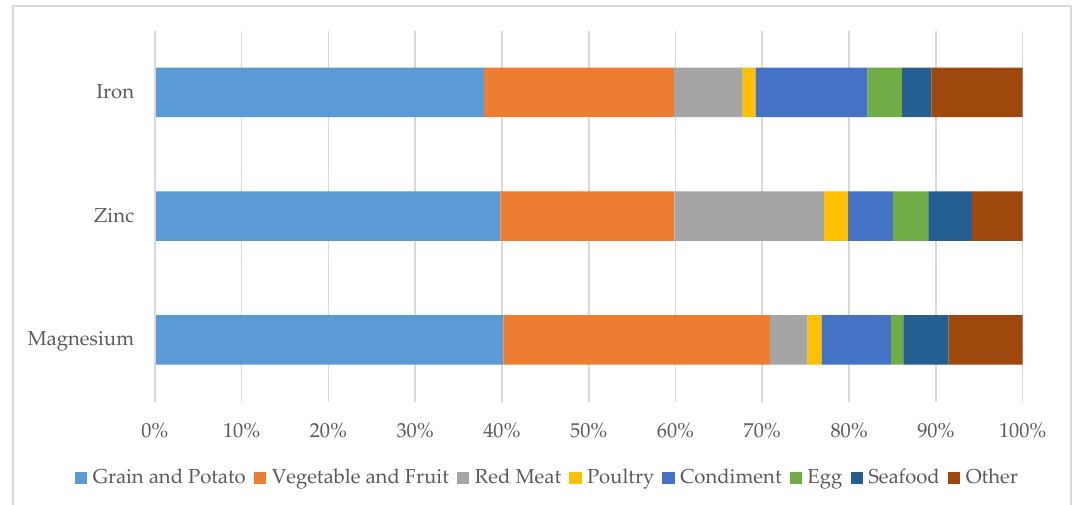
Figure 2. Dietary sources of iron, zinc and magnesium among 5323 participants from CNHS and SDHS. Table 4. ORs (95% CI) for MetS according to the quartiles of dietary iron, zinc and magnesium intakes (mg/day) in 5323 participants from CNHS and SDHS, stratified by food sources 1, 2 .